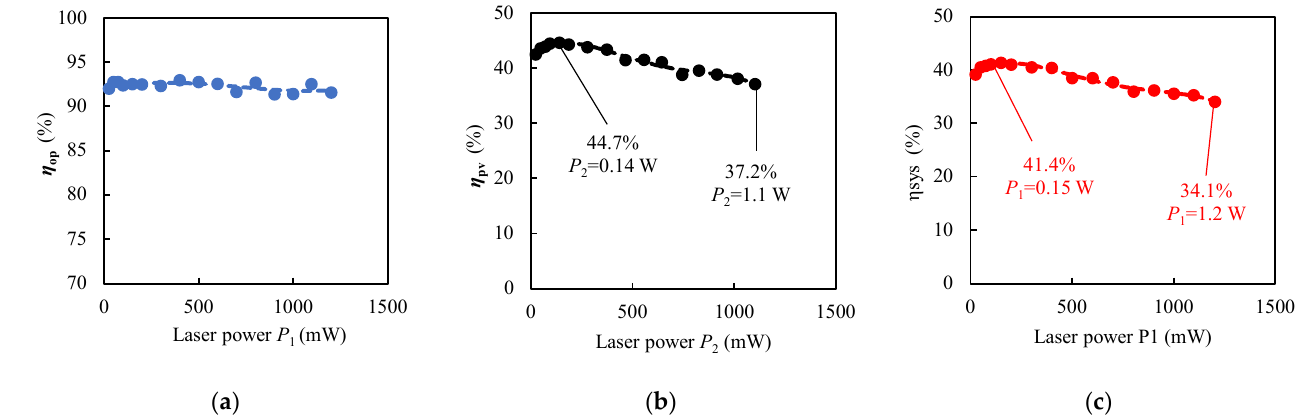
Figure 4. Plots of the optical reaching rate ( a ), photoelectric conversion efficiency ( b ), and system efficiency ( c ).